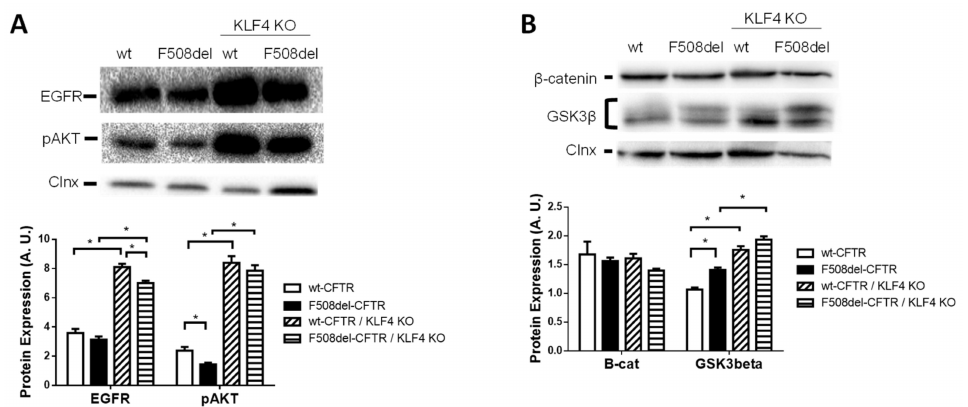
Figure 4. Marked alterations in epidermal growth factor receptor / phosphorylated serine / threonine kinase 1 (EGFR / pAKT) and glycogen synthase kinase 3 beta (GSK3 β ) signaling pathways were observed. ( A , B ) Representative WB of ( A ) EGFR and pAKT, ( B ) beta-catenin and GSK3 β expression in wt- and F508del–CFTR CFBE and their respective KLF4 knockouts. Calnexin was used as loading control. Data are normalized to loading control and showed as arbitrary units below (A.U.) (n = 3, unpaired t -test, p < 0.05).